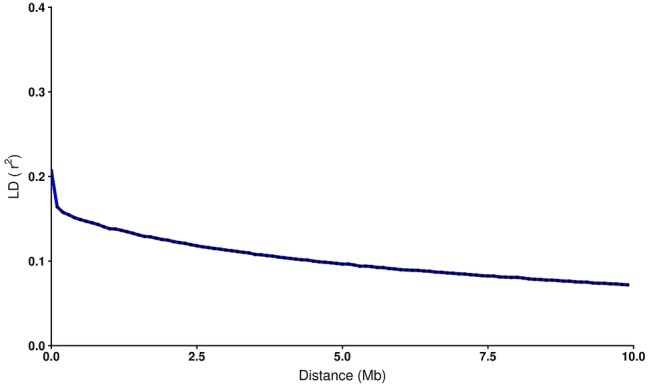
Decay of average LD (r2) over distance among SNPs in coho salmon (Oncorhynchus kisutch) population. The blue line shows the mean LD in each 100 kb sliding window. Each black dot represents average r2 within each bin.